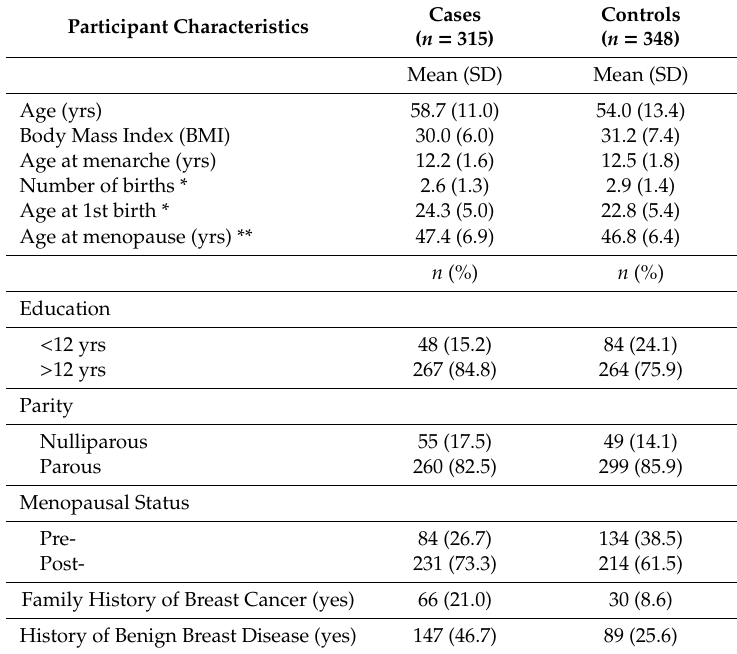
Table 1. Characteristics of Atabey Study Participants by Case-Control Status (2009–2014).